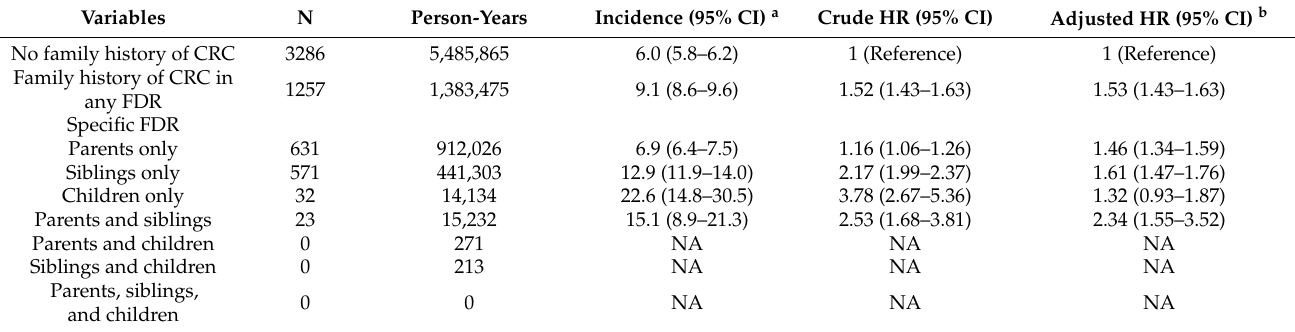
Table 3. Risk of CRC according to family members affected by CRC.